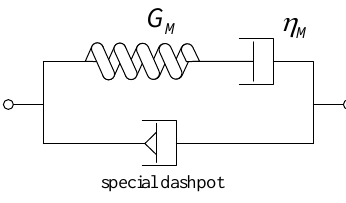
Figure 2: Diagram of the quasi-Jeffreys model The structural recovery process of thixotropic viscous